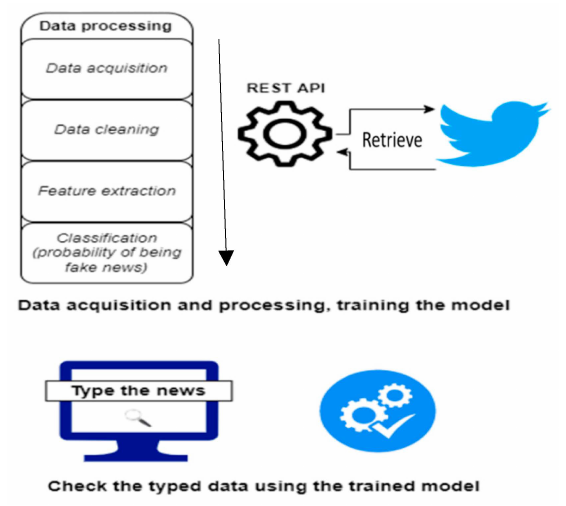
Figure 2. The conceptual